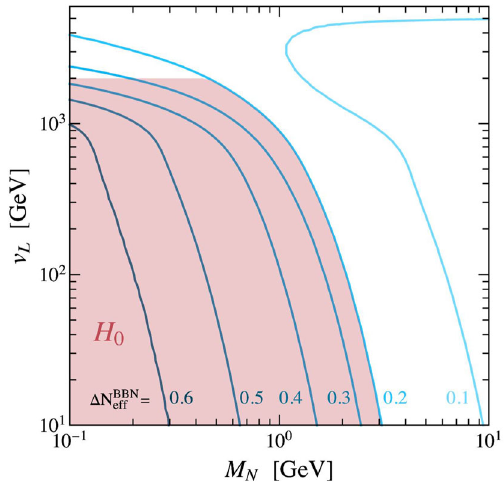
Fig. 3 (cid:2) N eff at BBNas a function of the sterile neutrino mass M N and the scale of lepton number breaking v L . We have highlighted in red the approximate region preferred to solve the Hubble tension (defined here as the region for which (cid:2) N eff (cid:3) 0 . 2 and v L ≤ 2 TeV). Various (cid:2) N eff contours are highlighted in blue, including the approximate fiducial modeladoptedlaterinthisworkwhichroughlycorrespondsto (cid:2) N eff ∼ (cid:2) [ 0 . 5 , 0 . 7 ] , with the 0 . 4. Note that BBN constrains imply (cid:2) N BBN eff uncertainty reflecting different measurements of the primordial Helium abundance, see Appendix